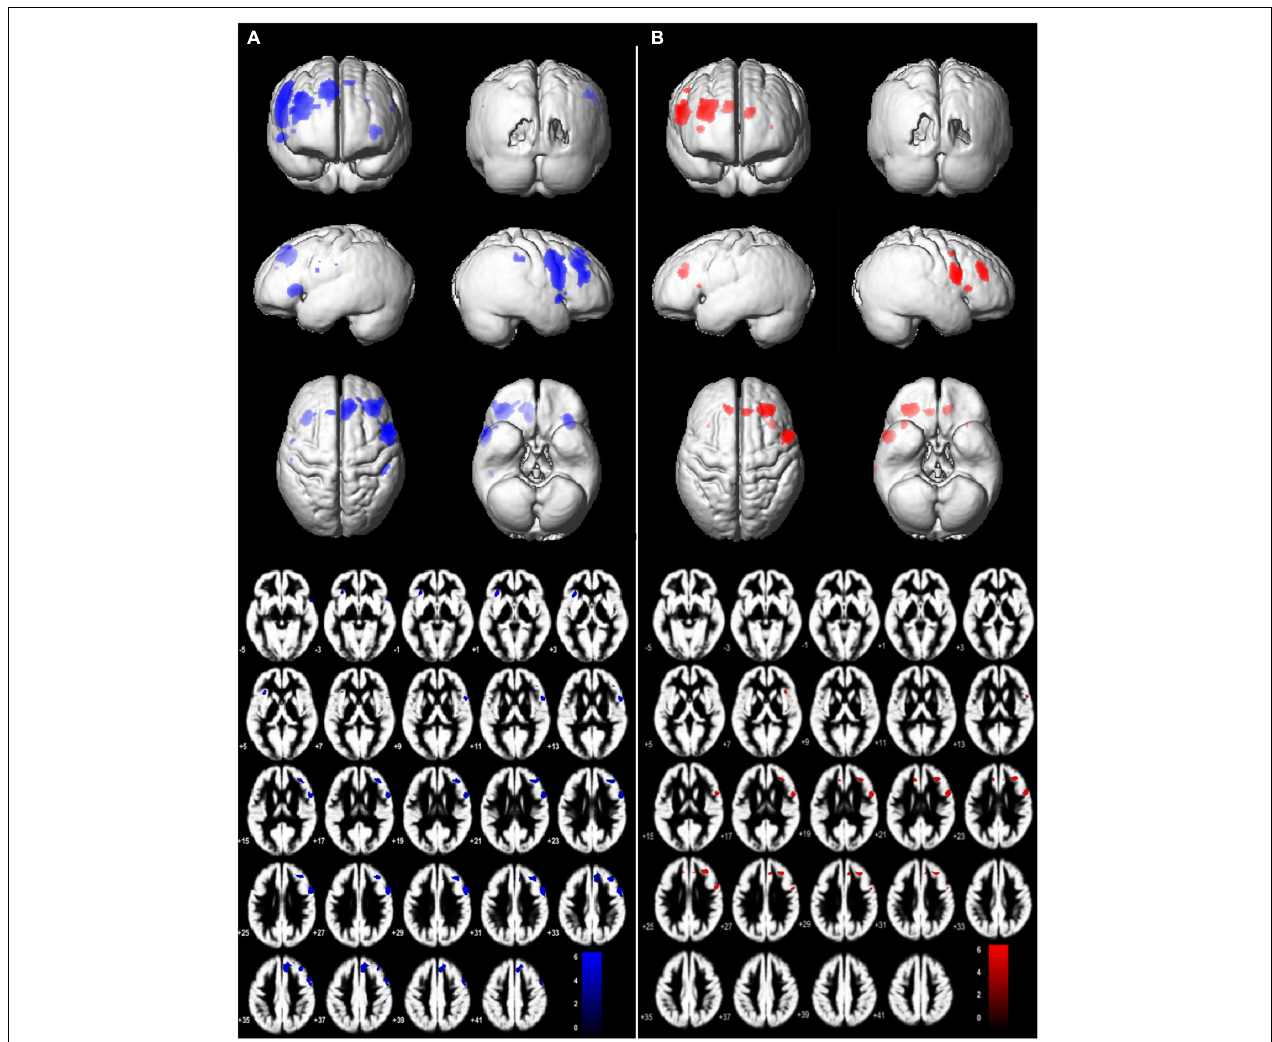
FIGURE 3 | Brain regions with significant main effect condition in ( JPS > Rest ) > ( Flex > Rest ), P = 0.05, family-wise corrected, voxel limit 15. Slices –5:2:38 mm (MNI) in inferior-superior direction are shown. Group mean brains (Dartel) are used for the illustration for (A) left-side analyses – L-ACLR moving their injured left leg and CTRL moving their left non-dominant leg, and (B) right-side analyses – R-ACLR moving their right injured leg and CTRL moving their right non-dominant